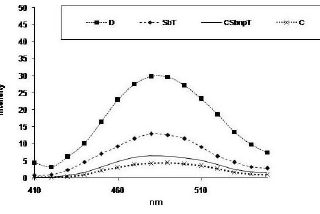
Figure 9. Effect of Sb and CSbnp on formation of advanced glycated end product (AGE). C- control group, D – diabetic group, SbT – Sb treated group, CSbnpT – CSbnp treated group. doi:10.1371/journal.pone.0101818.g009 PLOS ONE |